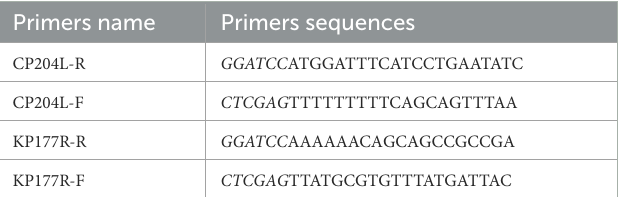
TABLE 1 The sequences of